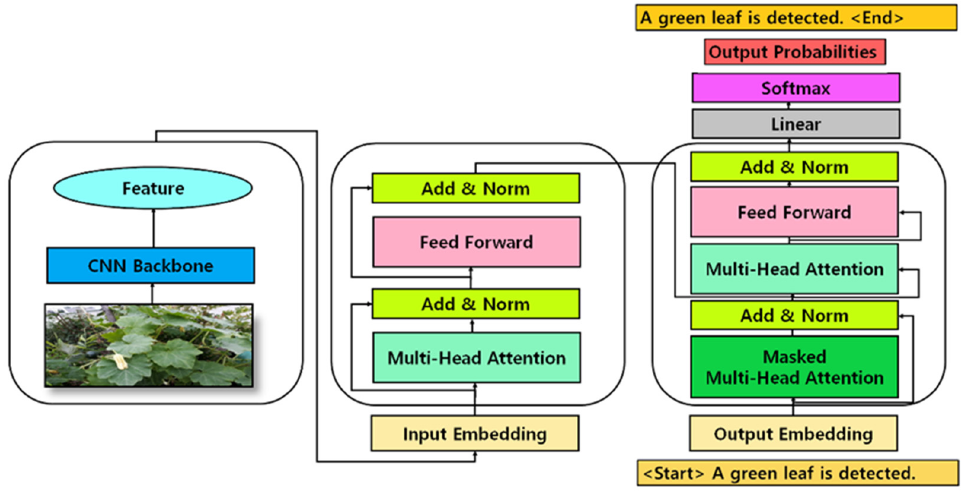
Figure 8. Structure of Image Captioning Model.